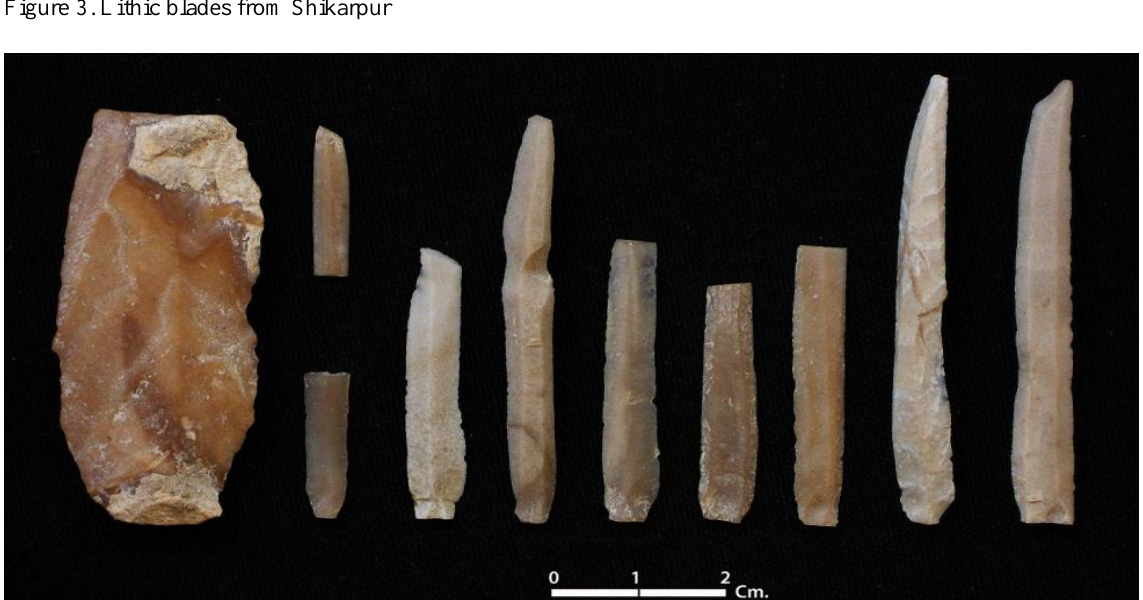
Figure 4. Lithic Debitage of Rohri chert from